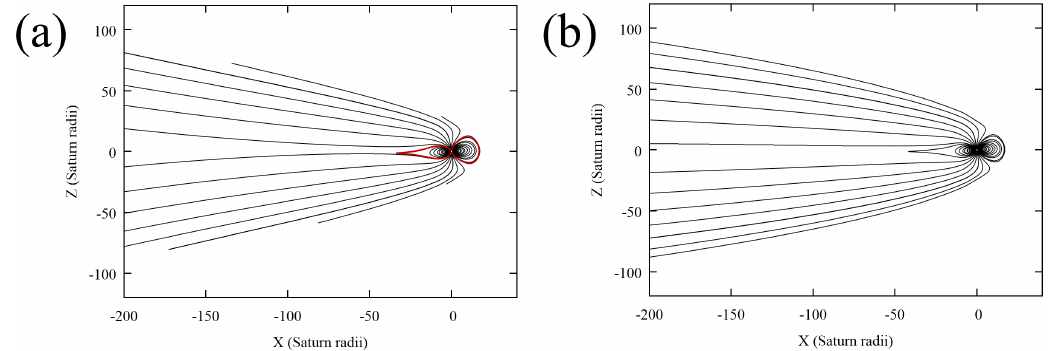
Figure 5. The same as in Fig. 4, but for case 10 from Table 1 with IMF vector ( − 0.1; 0.3; 0.3)nT. The red lines in panel (a) mark